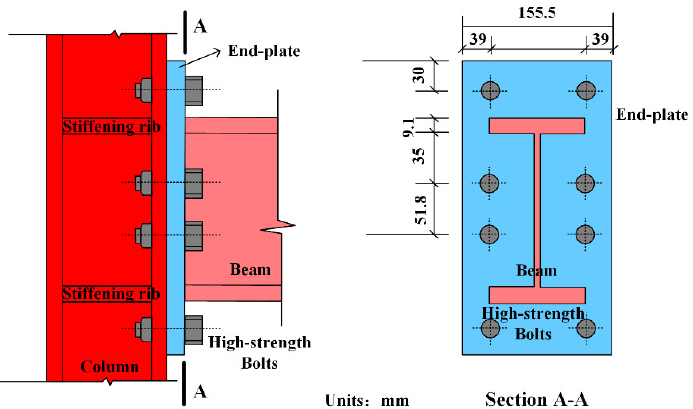
Figure 3. Schematic diagram of beam–column connection.